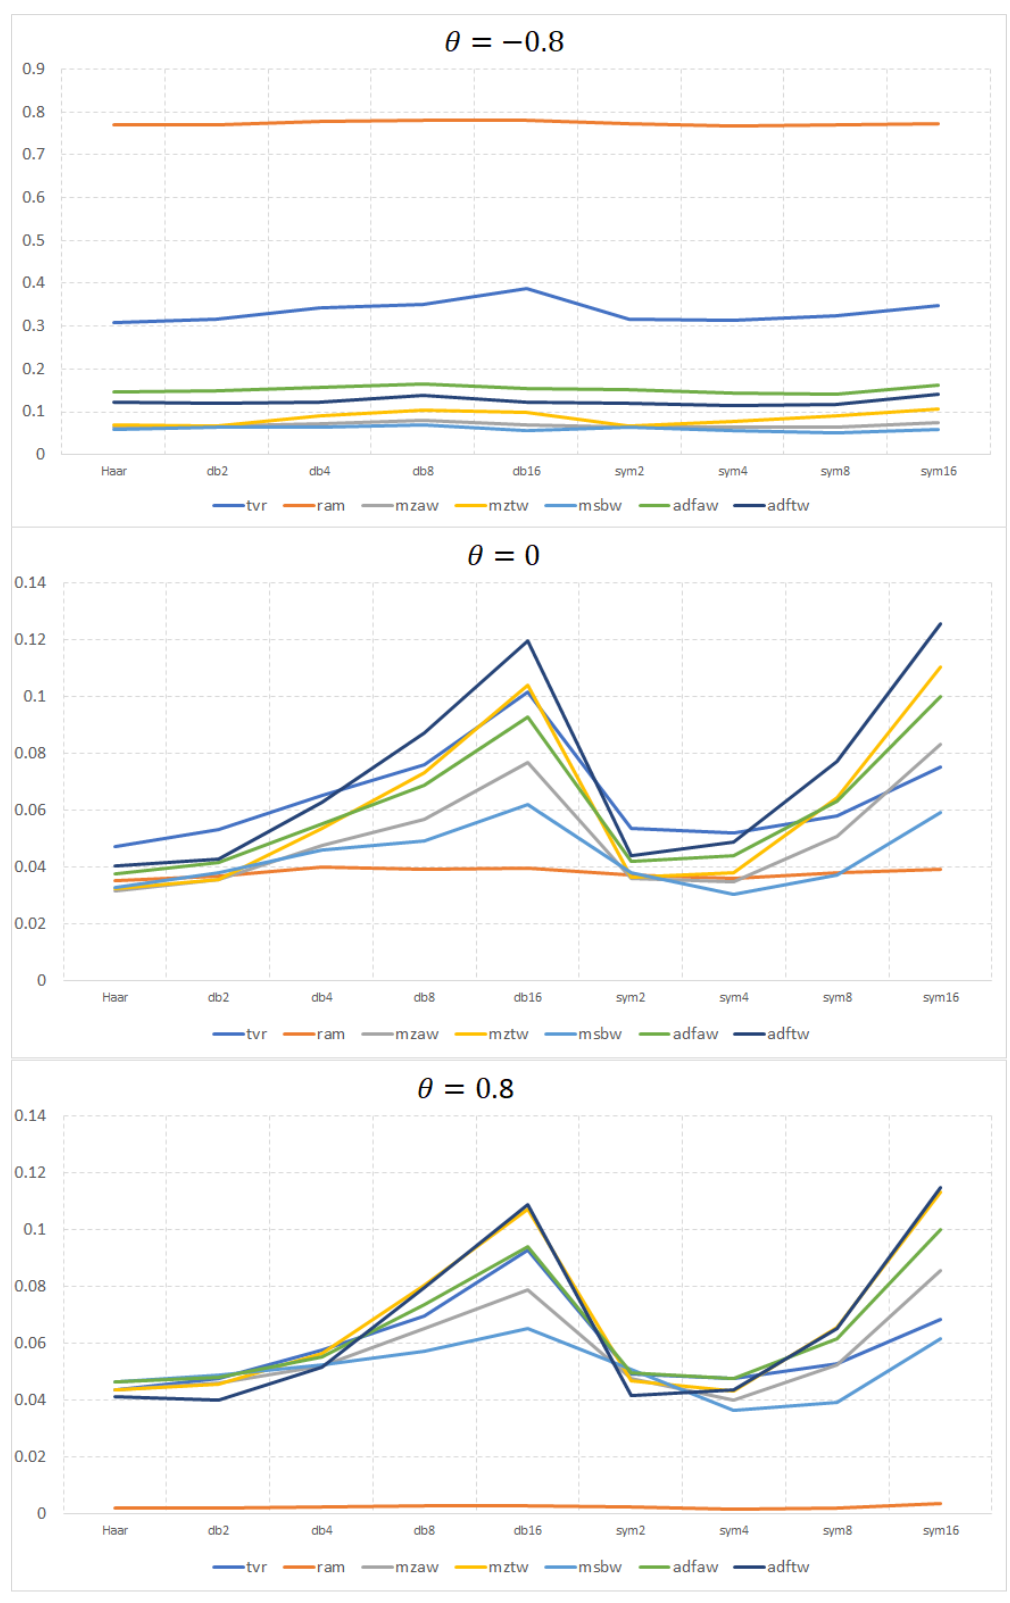
Figure 1. The size comparison of tests with various wavelet lengths with sample size T = 100. Note: tvr, ram, mzaw, mztv, msbw, adfaw and adftw correspond to τ ∗ , FG , MZ ∗ α , MZ ∗ t , MSB ∗ , ADF ∗ α , and ADF ∗ t ,